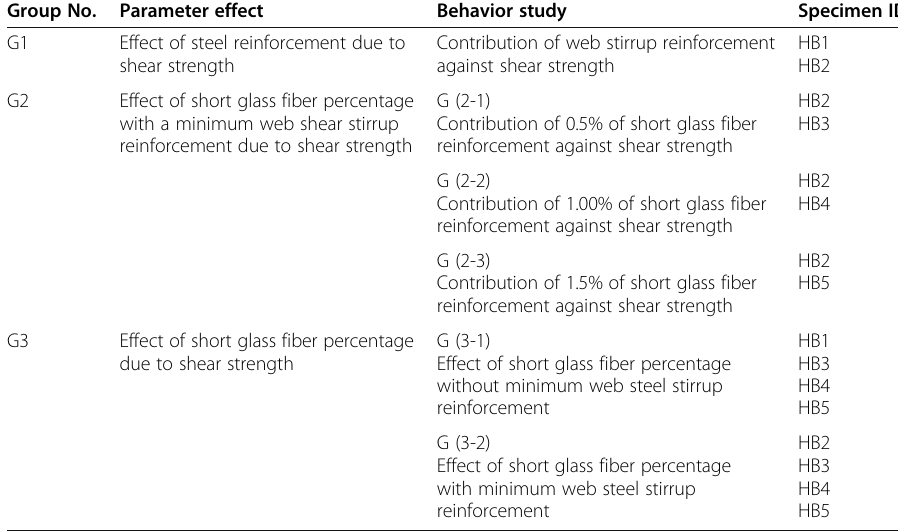
Table 6 Experimental work